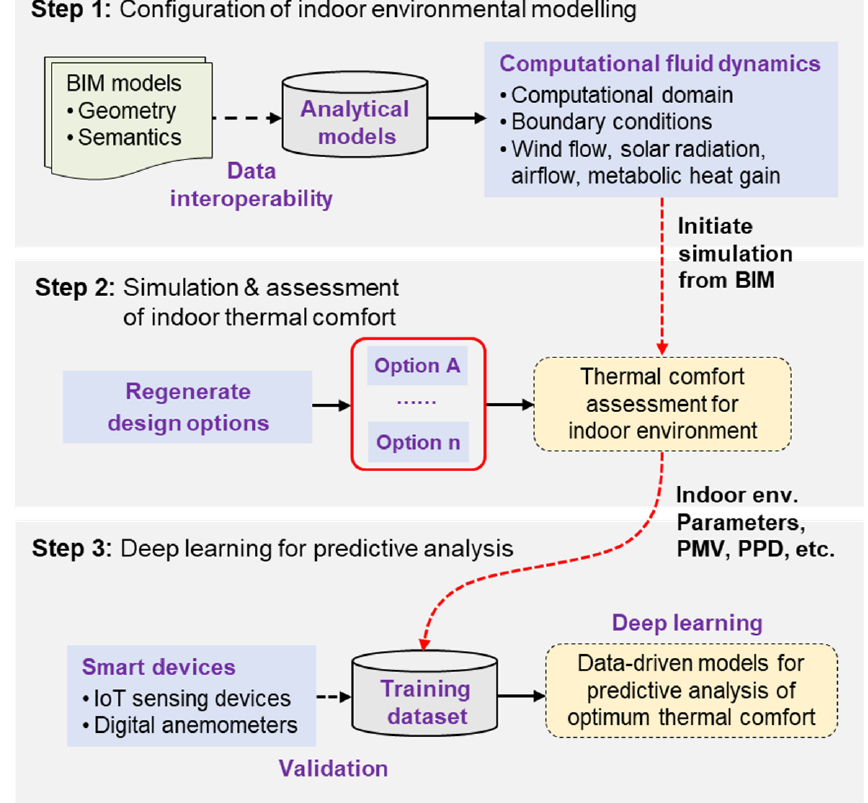
Figure 1. Proposed BIM-enabled data-driven framework for predictive analysis and optimization of thermal comfort.